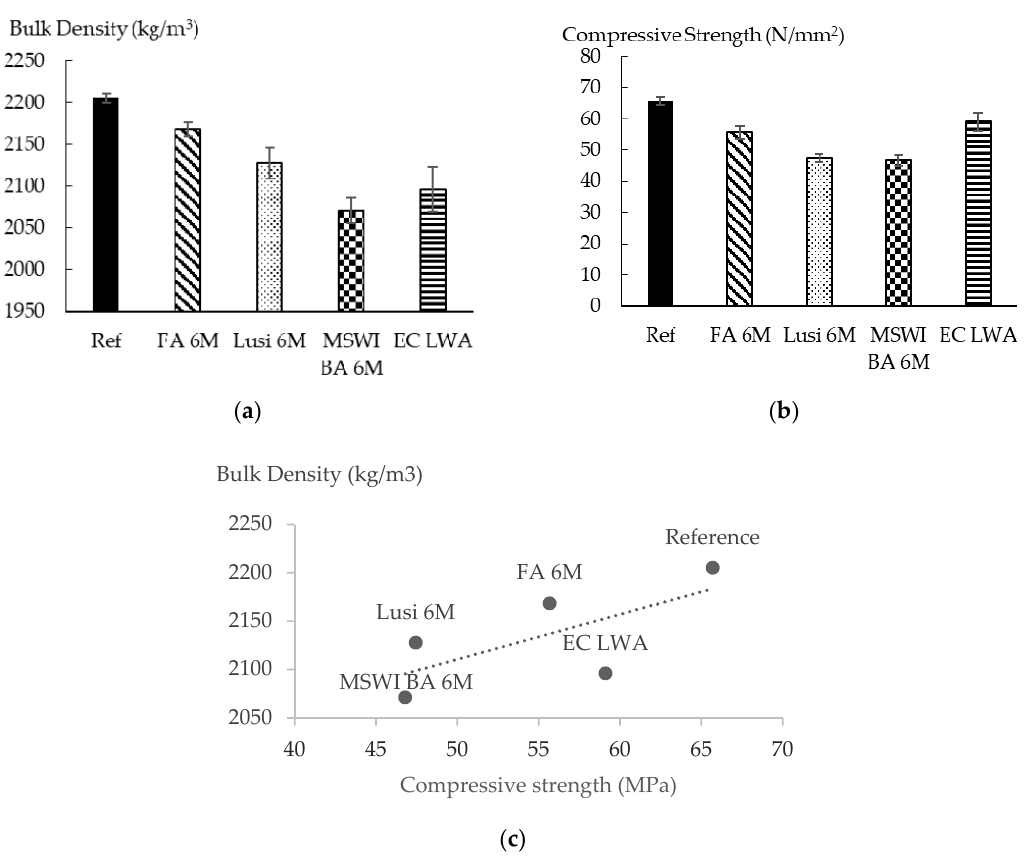
Figure 10. ( a ) Bulk density, ( b ) Compressive strength, ( c ) Correlation between compressive strength and bulk density of mortar containing LWA.